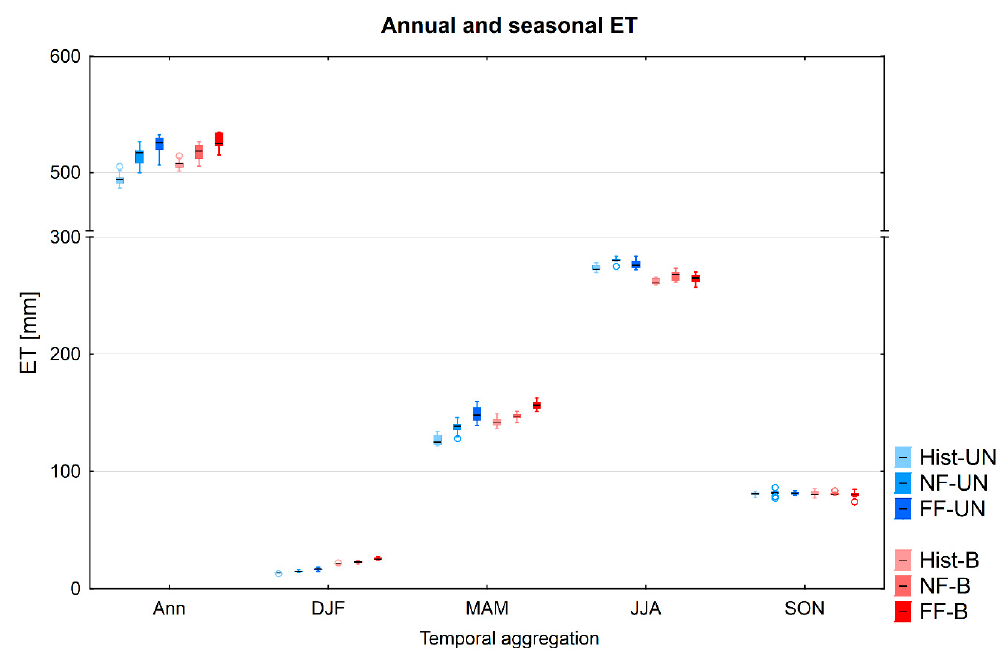
Figure 7. Multi-model ensemble projections of annual and seasonal actual evapotranspiration (ET) for the near (NF) and the far (FF) future under RCP 4.5 in comparison to the historical (Hist) period. B stands for the Barycz catchment and UN stands for the Upper Narew catchment.